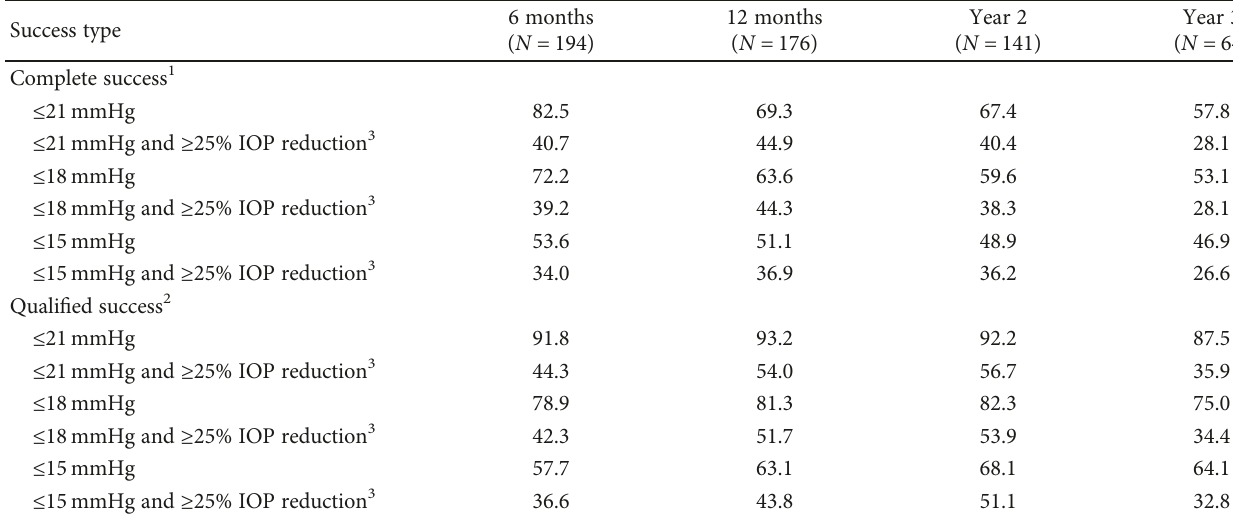
Table 5: Success rates (all eyes).